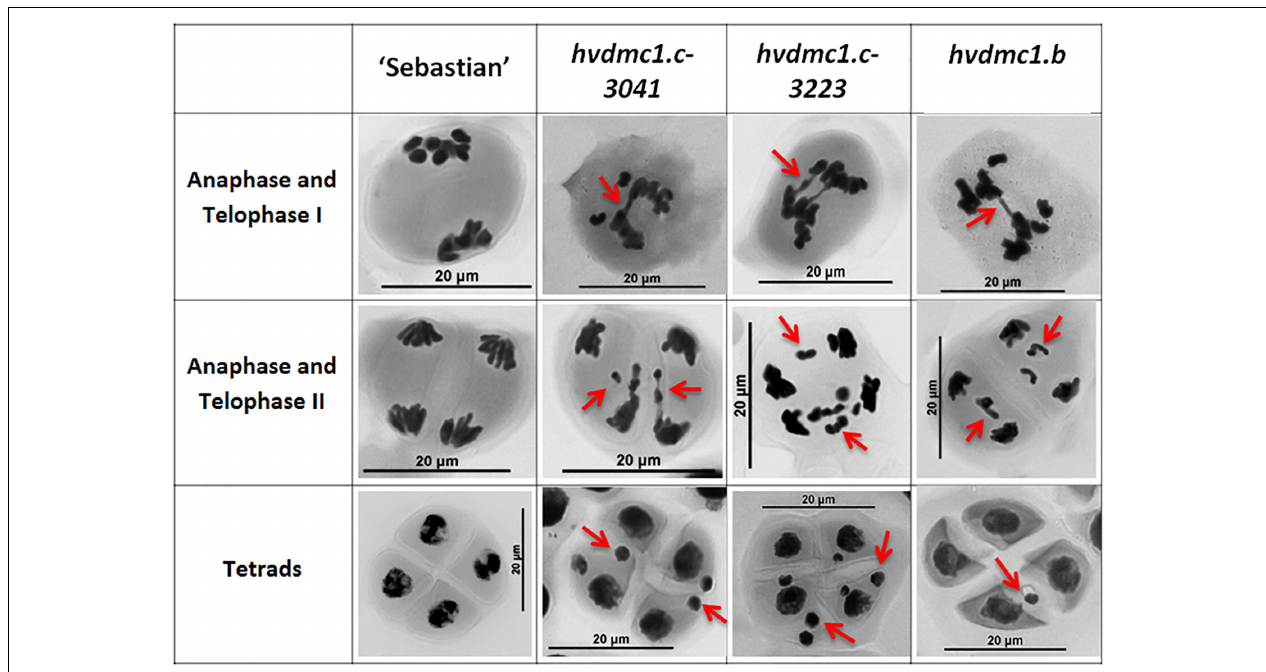
FIGURE 5 | The summary panel with the examples of meiotic cells in different stages: anaphase/telophase I, anaphase/telophase II and in tetrads in ‘Sebastian’ and the dmc1.c-3041, dmc1.c-3223 and dmc1.b mutants. In the anaphase and telophase I the chromosome bridges, in the anaphase and telophase II the chromosome fragments, whereas in tetrad stage the micronuclei are indicated by red arrows.